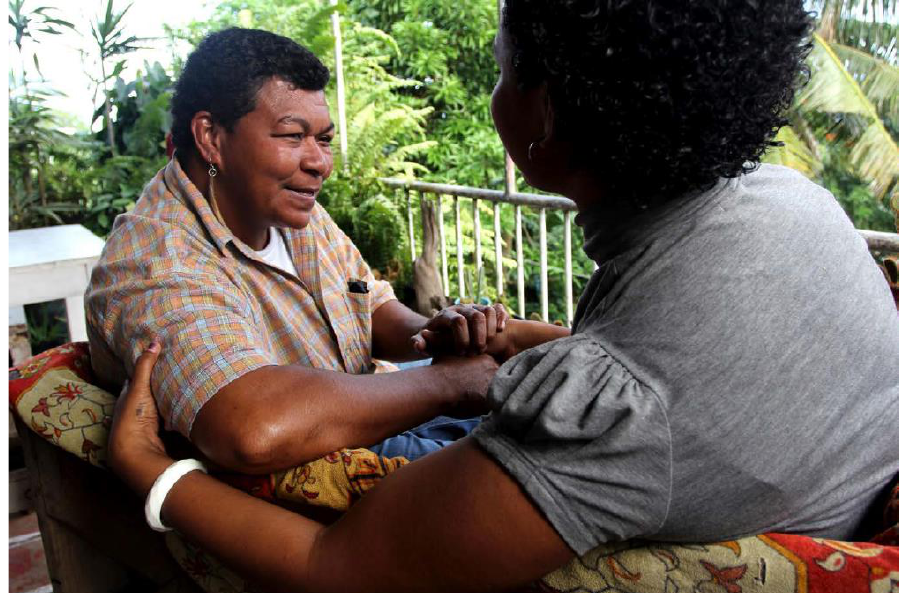
SCENARIO 10: Women’s sexual